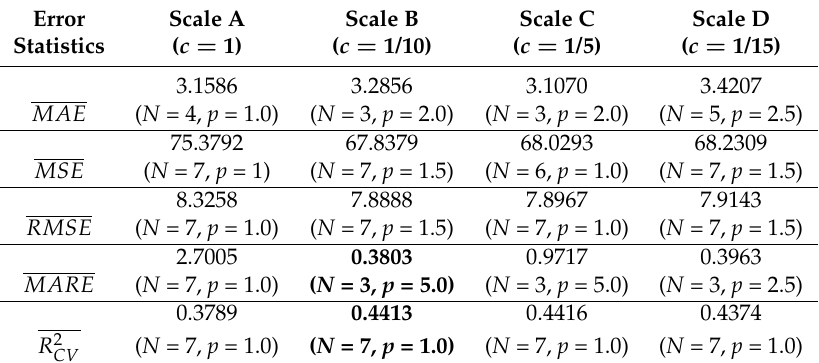
Table 4. Error statistics for the PM 2.5 data set using the IDW-based extension method and 10-fold